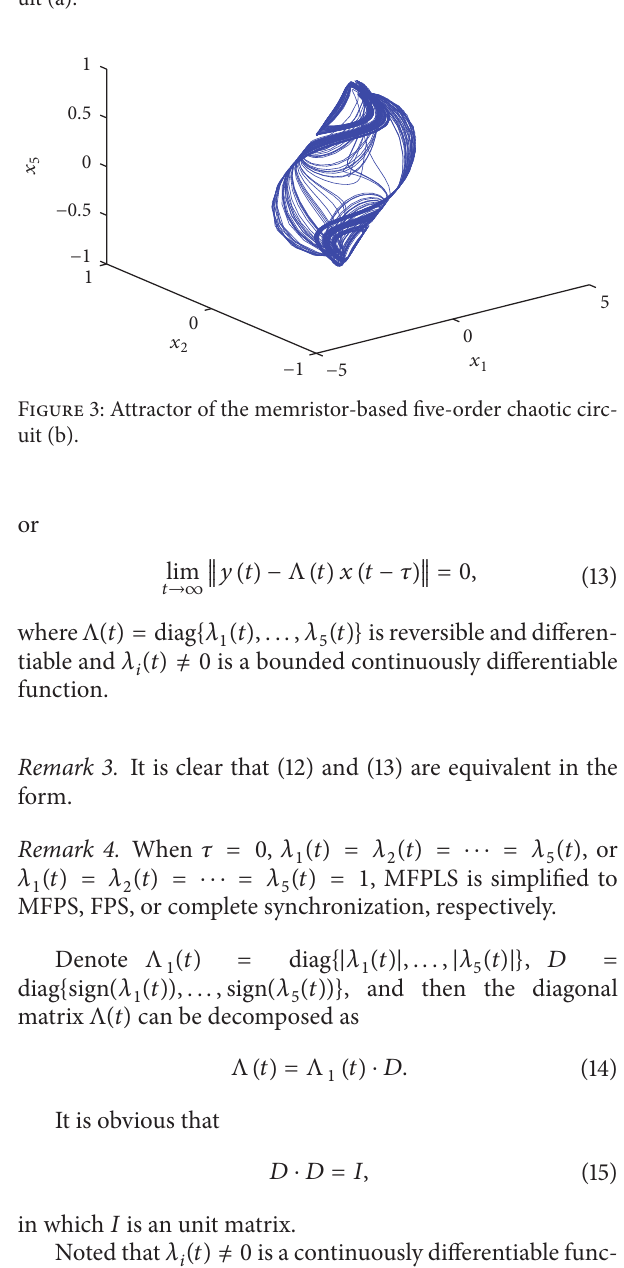
Figure 2: Attractor of the memristor-based five-order chaotic circ- uit (a).